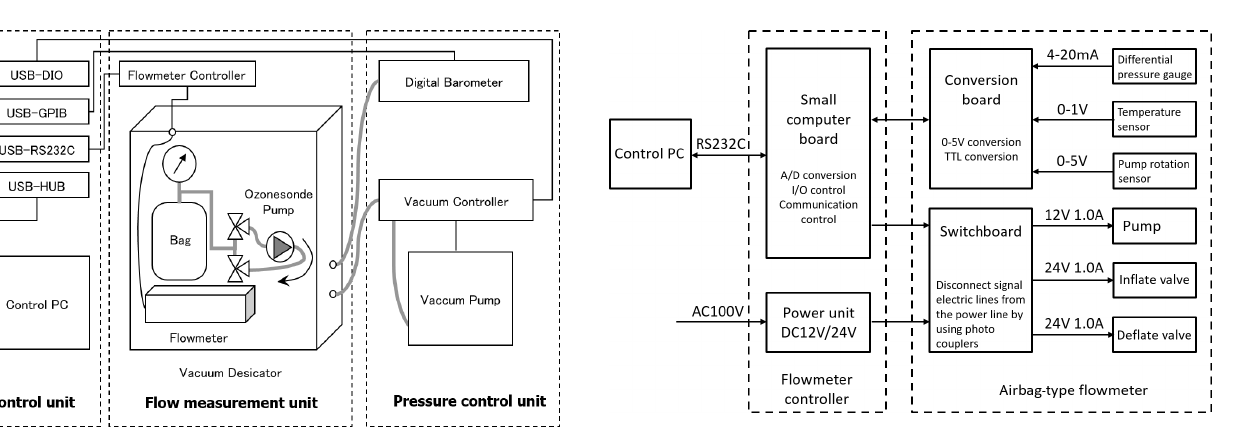
Figure 3. Automated pump-efficiency measurement system for ECC ozonesondes.